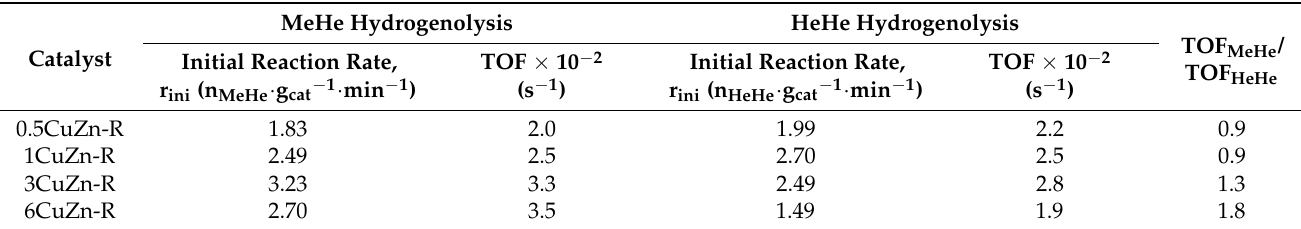
Table 4. Initial reaction rates and TOF values calculated for CuZn catalyst in MeHe hydrogenolysis. MeHe Catalyst